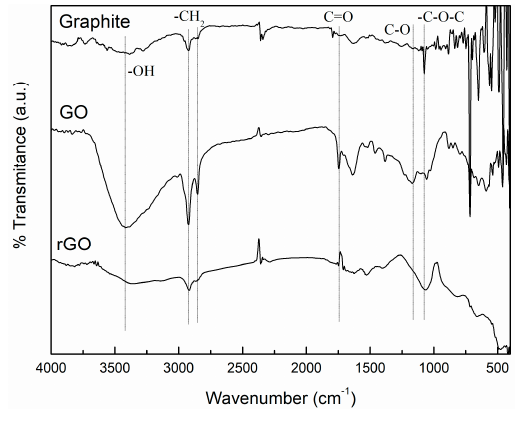
Figure 1. FTIR spectra of graphite, GO, and rGO.